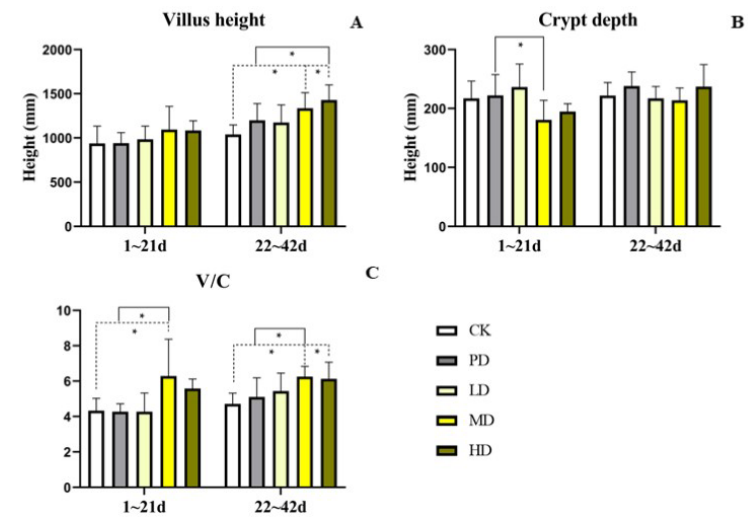
Figure 8. Effects of the fruit extract of K. coccinea on antioxidant function of white-feather broilers ( A ): villus height; ( B ): crypt depth; ( C ): The ratio of villus height to crypt depth; Note: Dotted line: compare with CK group; Solid line: compare with PD group; * indicate significant differences between groups according to the Tukey test; Supplementary Materials Table S8.